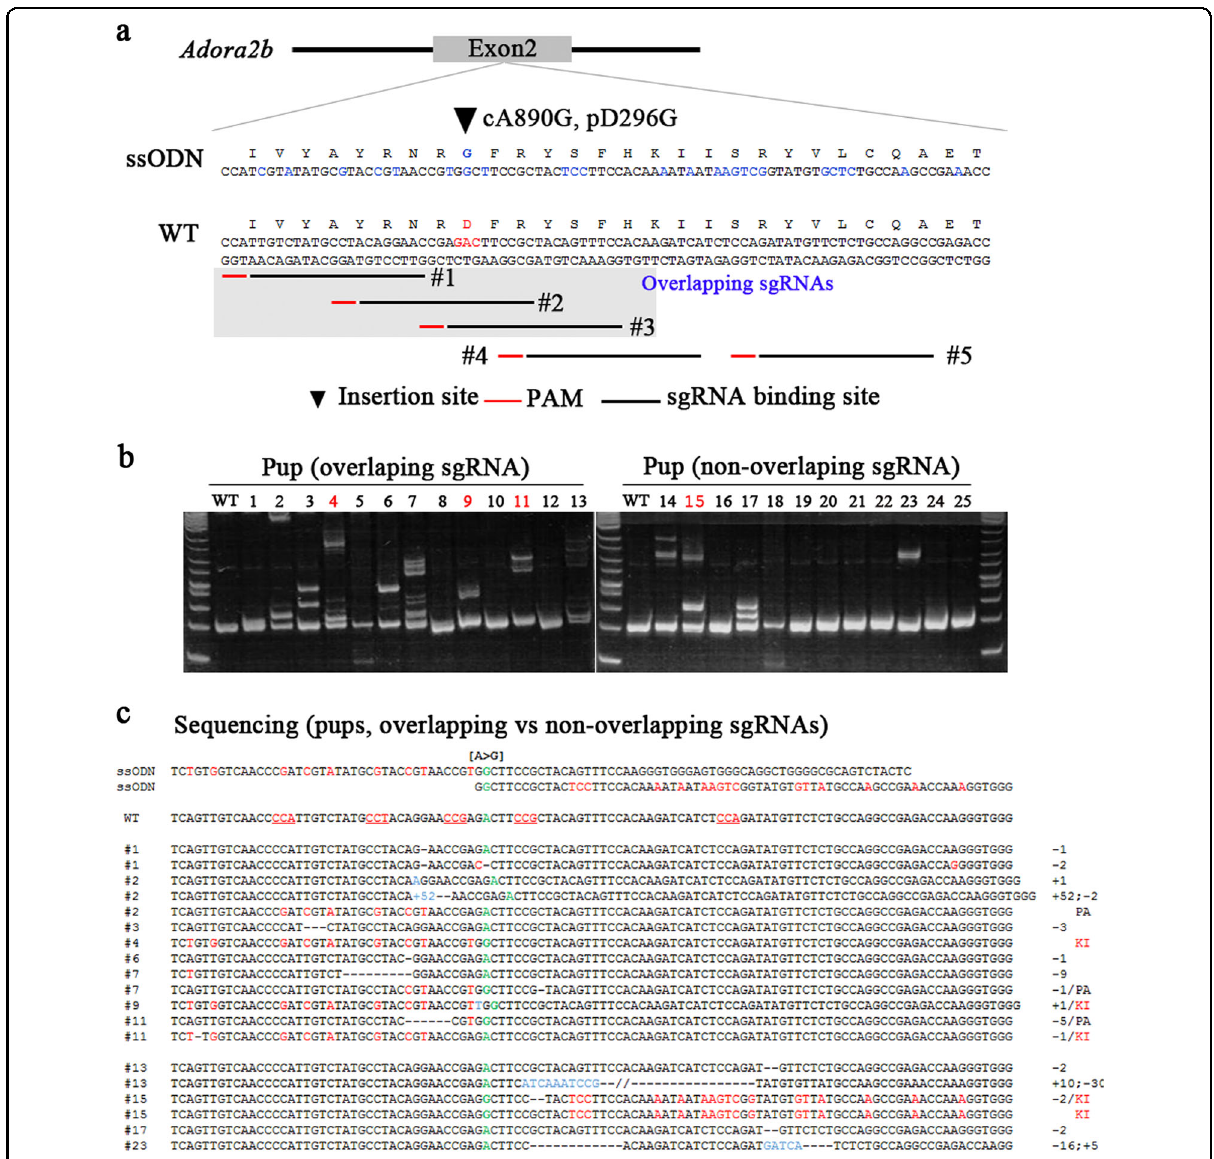
Fig. 4 Single-nucleotide substitution in zygotes with non-overlapping or overlapping sgRNAs into exon 2 of the mouse Adora2b locus. a A schematic diagram of the strategy for SNP induction (cA890G) with ssODN at the mouse Adora2b locus. The two different set of sgRNAs (non- overlapping; and overlapping, grey box) are shown. Blue letters indicate nucleotide alteration for amino-acid change and silent mutation for PCR- based genotyping. b PCR-based genotyping of pups and using speci fi c primers. Red letter indicate KI pups. c Sequencing-based analysis for obtained pups. Green letter indicate A – G nucleotide substitution site